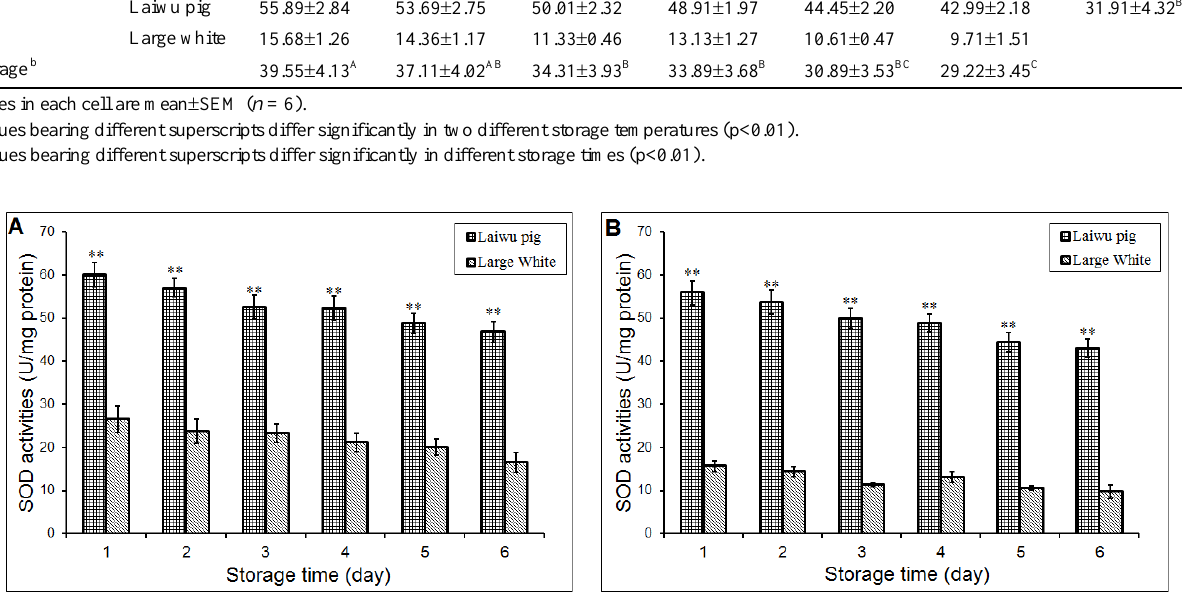
Table 2. CAT activity of porcine muscle stored at different days and temperatures Temperature